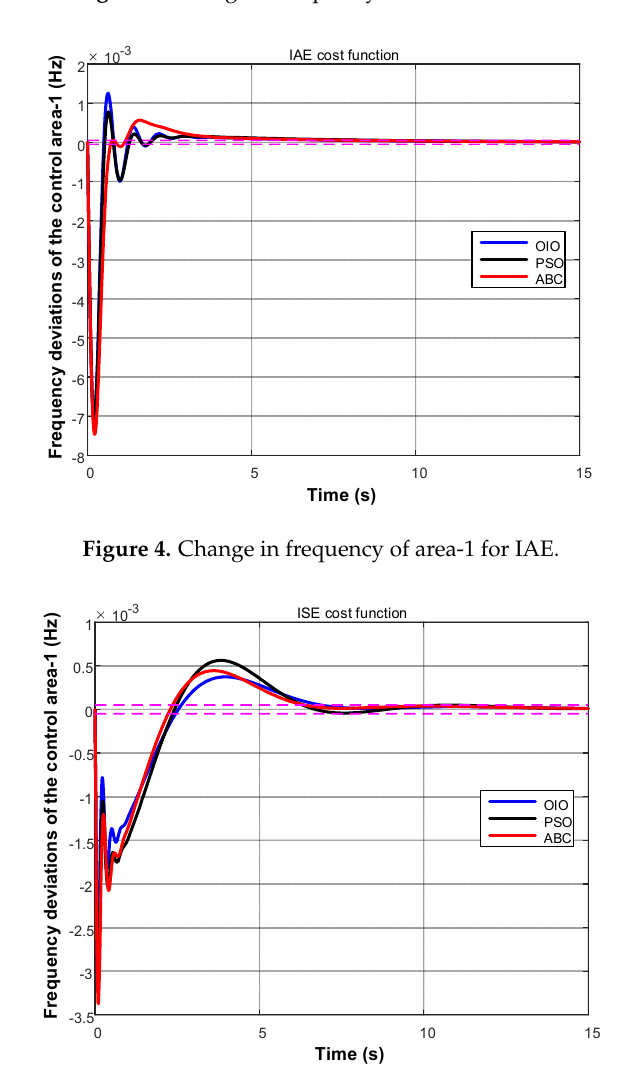
OIO PSO ABC Figure 6. Change in frequency of area ‐ 1 for ITSE. Time (s) 0 OIO PSO ABC Figure 7. Change in frequency of area ‐ 2 for ITAE.